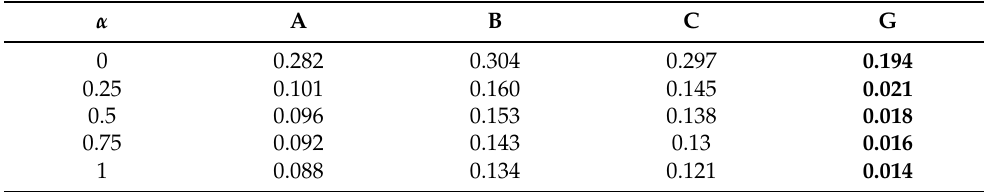
Table 3. Comparison of performance score for severe knee pain with kneeling.